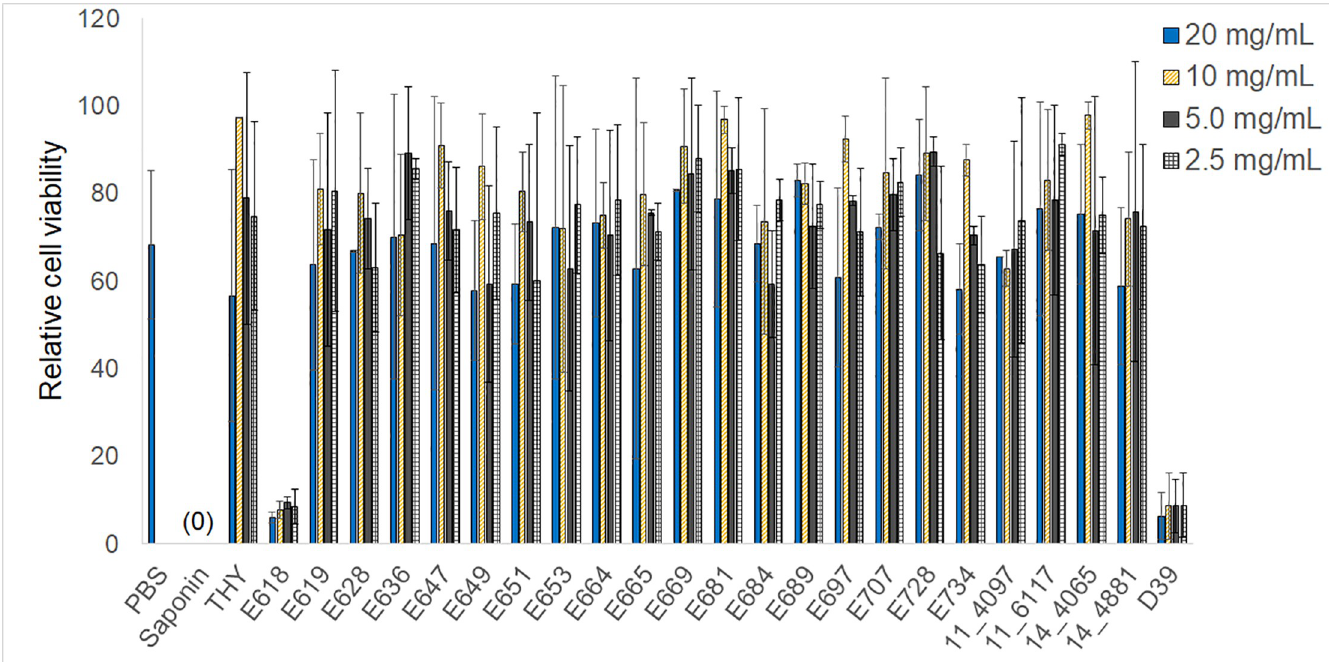
Fig 1. Relative mean viability of ARPE-19 cells following exposure to bacterial supernatants. Each supernatant at the indicated concentrations, in addition to PBS, THY, and saponin, is listed on the x-axis. The y-axis indicates relative viability after adjustment to a scale of 100 as described in the materials and methods. Error bars indicate standard deviation. Indicators of significant differences (described in the results) are not depicted to enhance figure clarity. Data represent the averages obtained from at least 2 independent experiments.